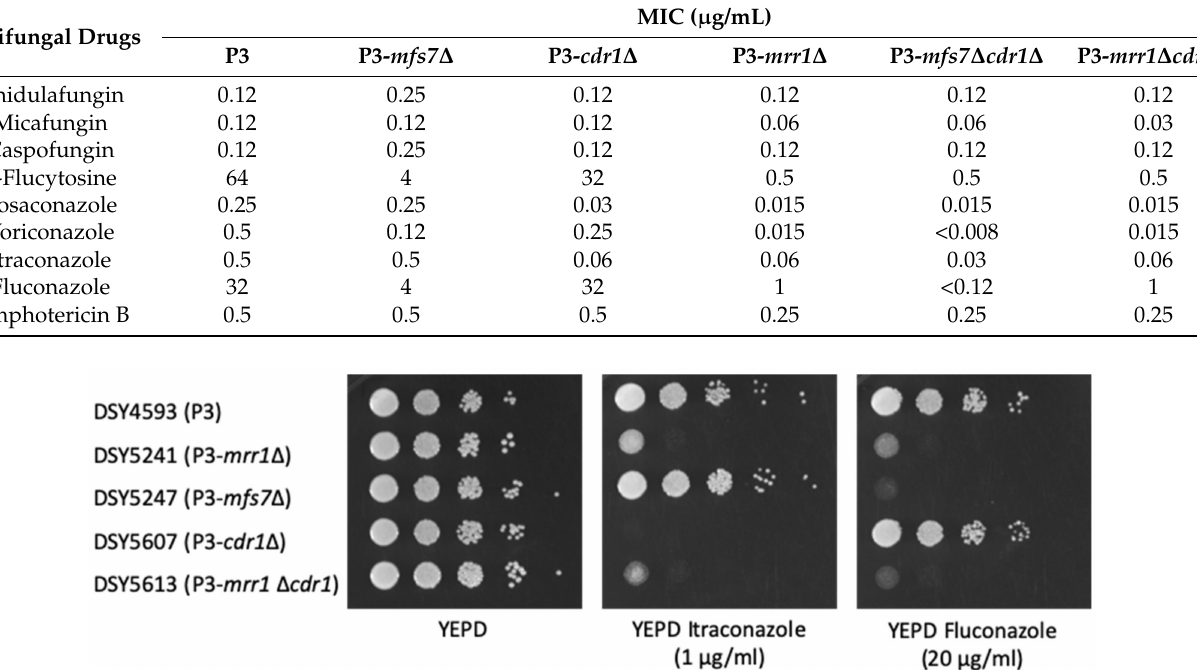
Figure 4. Serial dilution assays for itraconazole and fluconazole. Isolates were 10-fold serially diluted and spotted in the corresponding agar plates starting from approximately 10 7 cells/mL from inoculum cultures. Plates were incubated at 35 ◦ C for 24